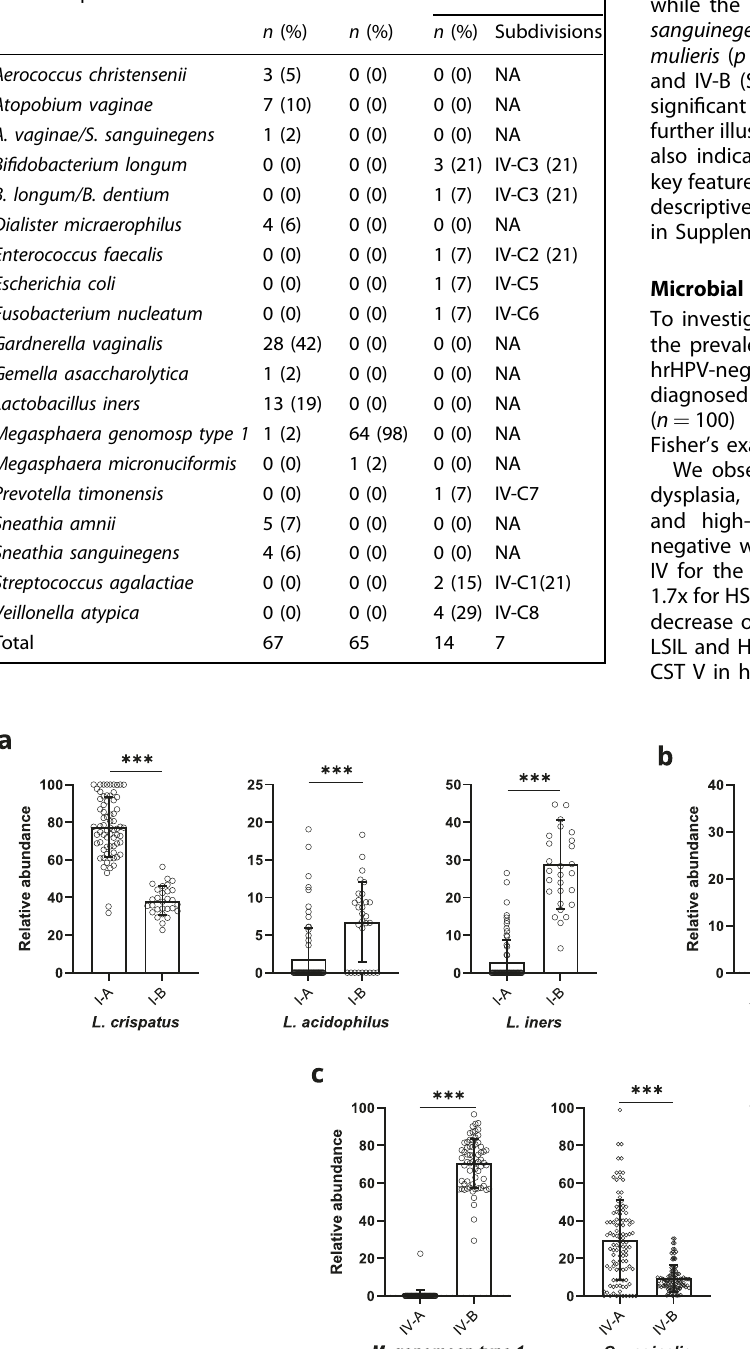
Table 1. Bacterial dominance within CSTs IV-A, IV-B, and IV-C. Bacterial